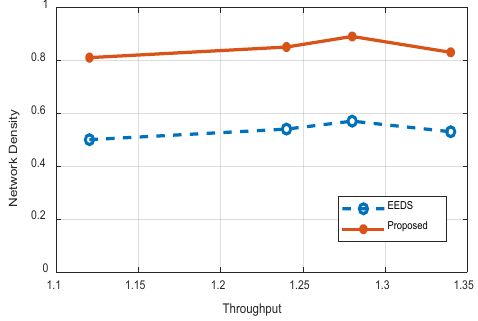
Figure 12. Network Density Versus Throughput